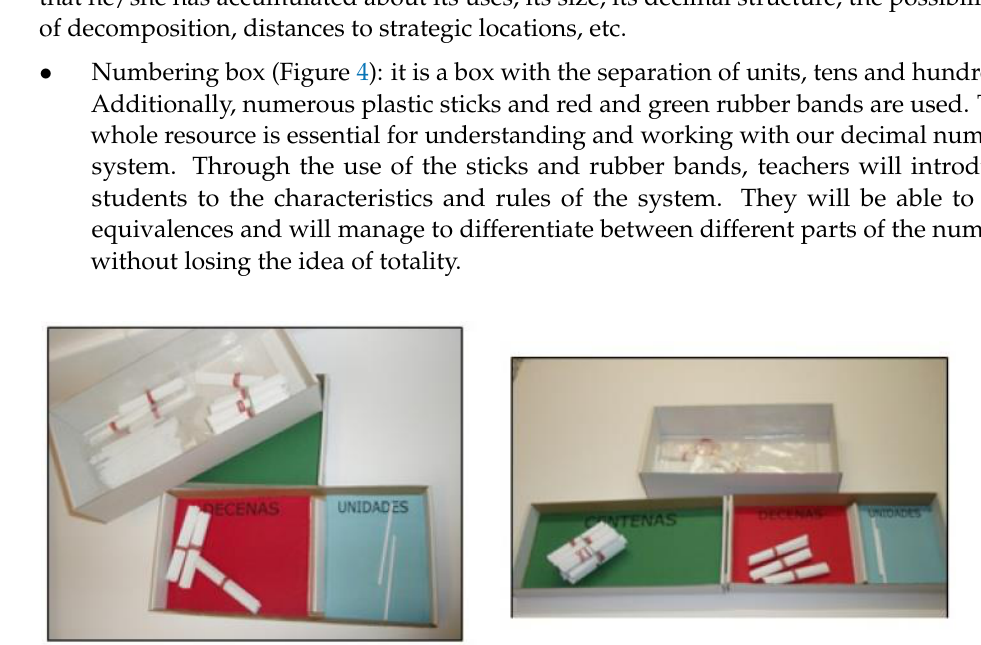
represented symbolically. By connecting the representation in the box with the numbers on the tape and the panel, children will perceive that the position of the number is relevant, as each space in the box holds very different